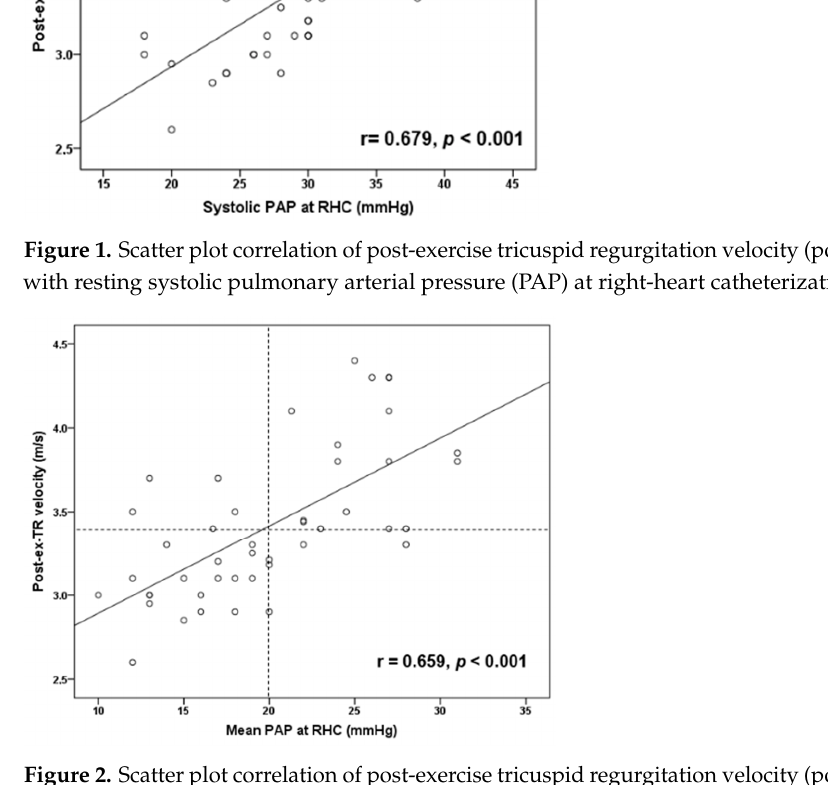
Figure 4. Scatter plot correlation of maximal achieved workload in METs with right ventricular (RV) inotropic reserve defined by the difference between post-exercise and prior to exercise S wave of RV, i.e., Δ (S(RV)).